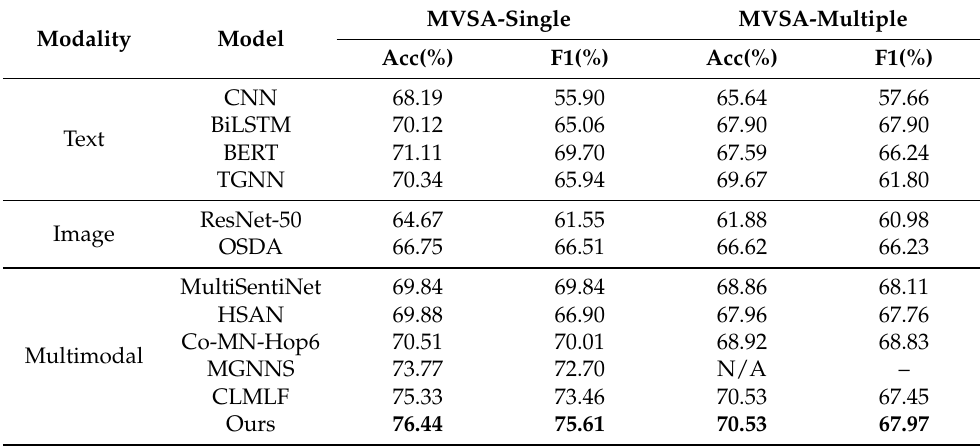
Table 2. Using the MVSA dataset and HFM set, the results of the results show the ACC and F1 performance (%) of our designed model, and our experimental results are highlighted in bold.